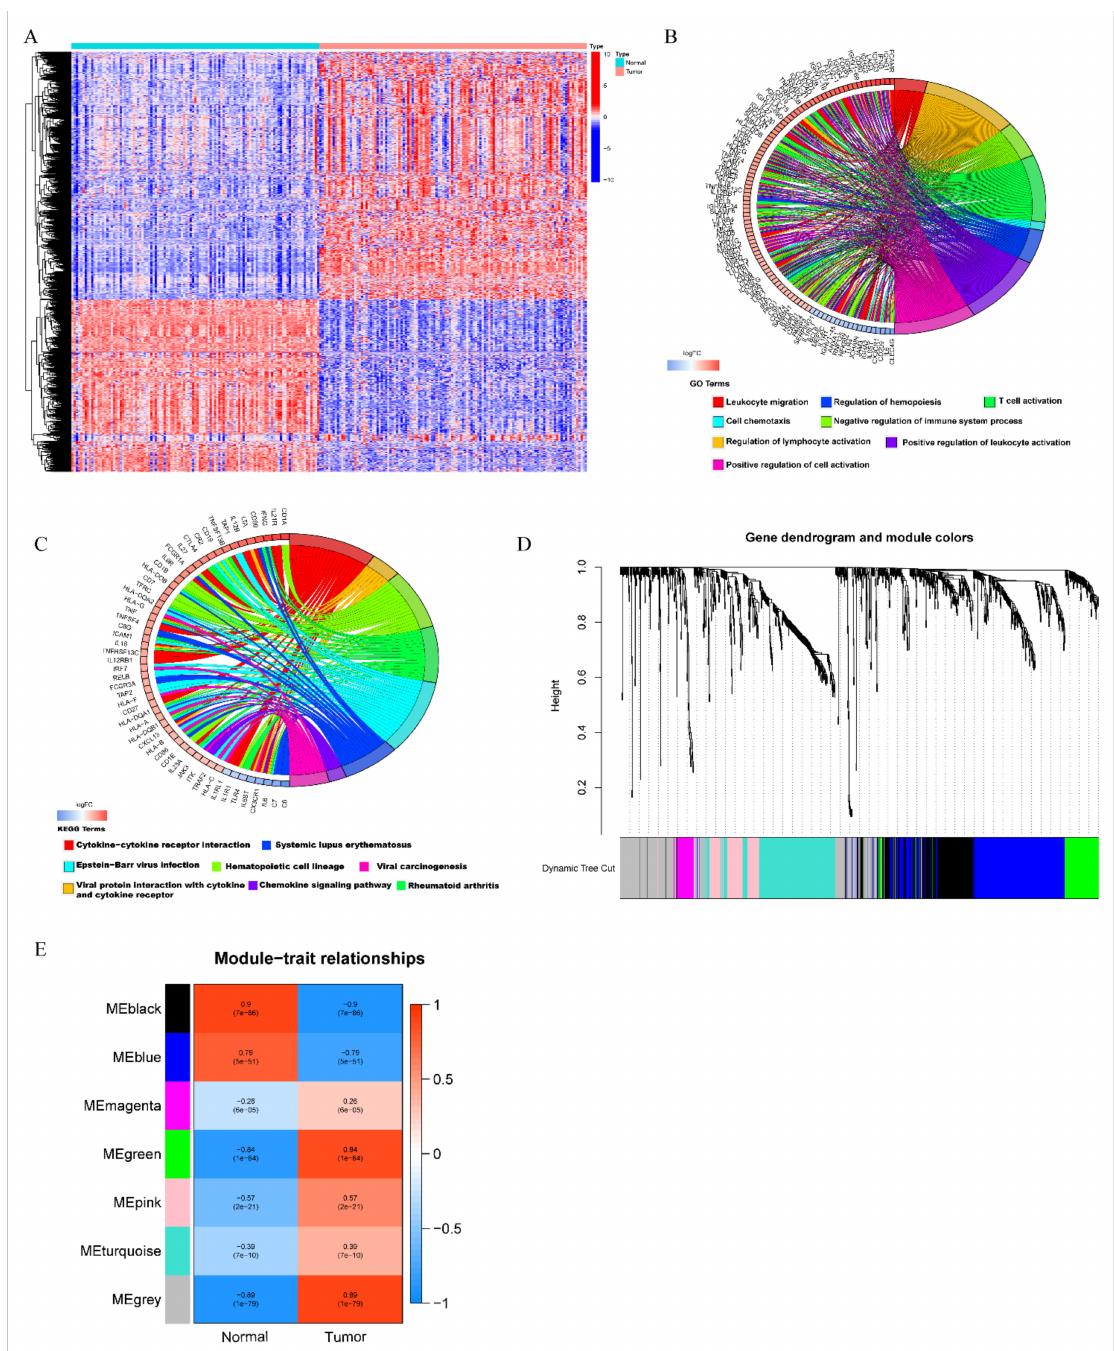
Figure 2. Identification of differentially expressed immune-related genes (DEIGs) and high immuno- genicity modules in TNBC. ( A ) Heatmap of differentially expressed immune-related genes between TNBC tumor samples (red) and normal samples (blue) using the “limma” method. ( B ) Circos graph for GO enrichment of DEIGs. ( C ) Circos graph for KEGG pathways analysis of DEIGs. ( D ) Clustering dendrogram of DEIGs. Each short vertical line corresponds to a gene. The branches are modules of highly interconnected groups of gene expression. Seven modules were identified, and the lower panel shows colors designated for each module. ( E ) The module–trait relationships between the identified modules and clinical status (normal and tumor). Rows are module eigengene (ME) regards to each module, and the columns indicate traits. Red represents high adjacency and blue represents low adjacency. The upper number in each cell indicates the correlation coefficient of each module in the trait, and the lower number is the corresponding p